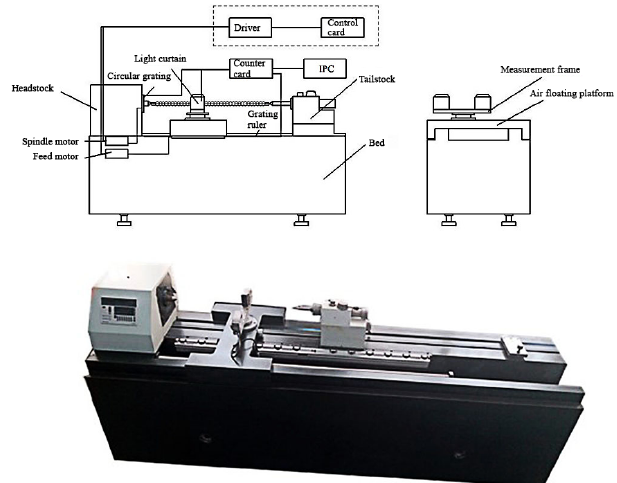
Figure 2. Schematic diagram of the mechanical